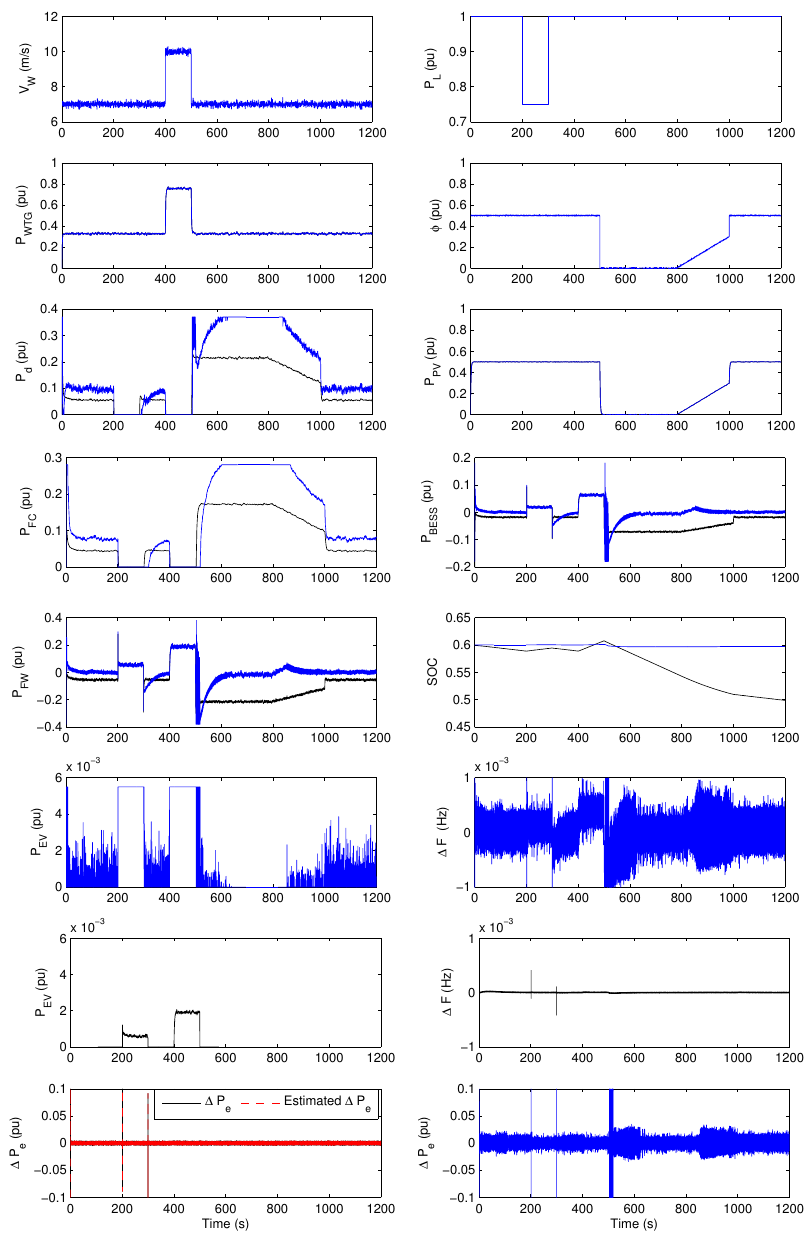
Figure 10. Case 3 simulation results: proposed (black) and conventional